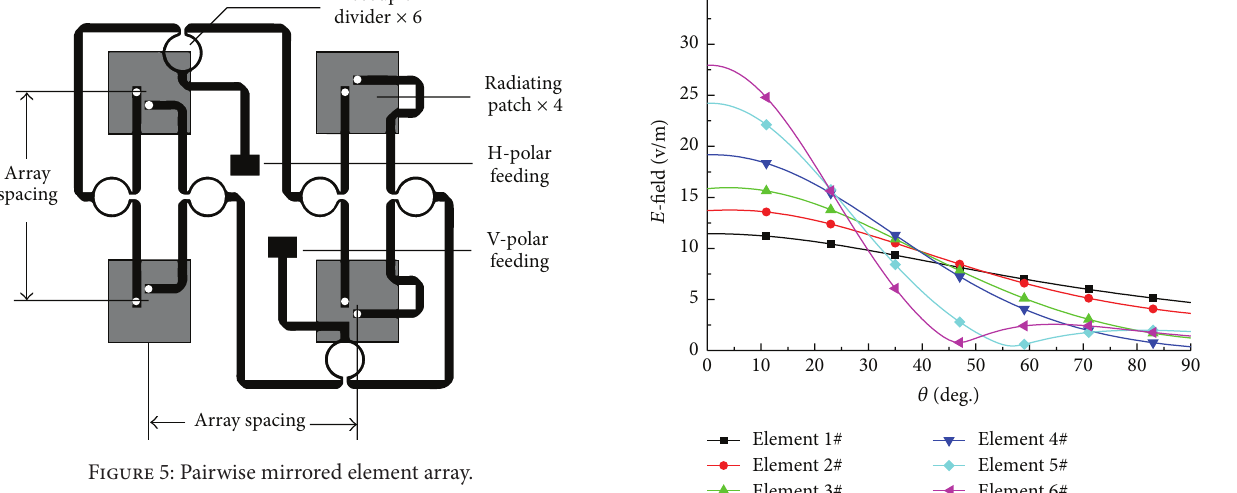
Figure 6: E -field pattern of designed elements.